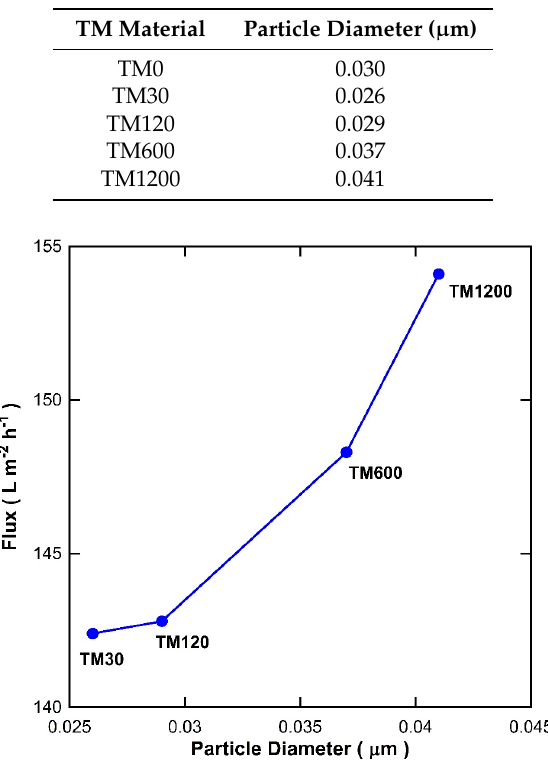
Table 2. Calculated titania particle sizes.